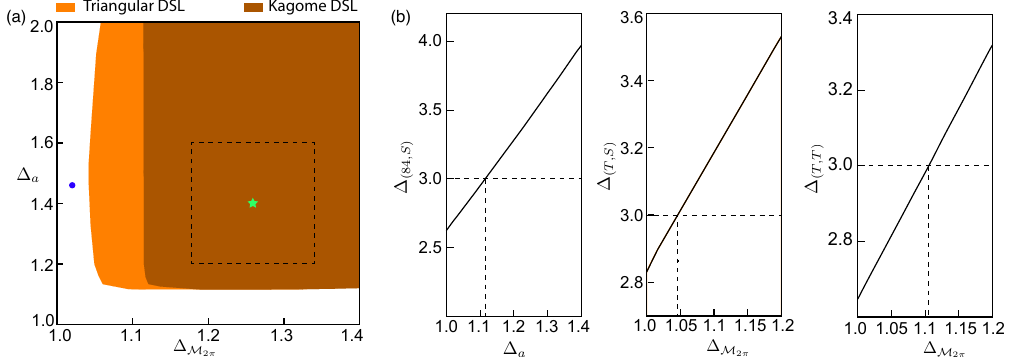
Figure 2: (a) The allowed region (shaded) from the mixed correlator of the fermion bilinear ( a ) and monopole ( π ). For the triangular DSL, we impose the gap con- M 2 > 3. For the kagome DSL, we impose two ditions ∆ ( , ∆ ( , ∆ ( , ∆ ( , ∆ ( S , S ) T , S ) V , V ) (cid:48) A , A ) (cid:48) 84, S ) > 3. The blue circle is the large- N more conditions ∆ ( , ∆ ( T , T ) 64, V ) = 4 QED N , while the green star is the estimate from the Monte Carlo simulation, f 3 with the error bars represented by the dashed line box. (b) The numerical bounds of ∆ ∆ ∆ ( 84, S ) , ( T , S ) and ( T , T ) from the single correlators. The last two numerical bounds were also reported in Ref. [ 51 ] . The allowed region is below the black curve. Here we take Λ =